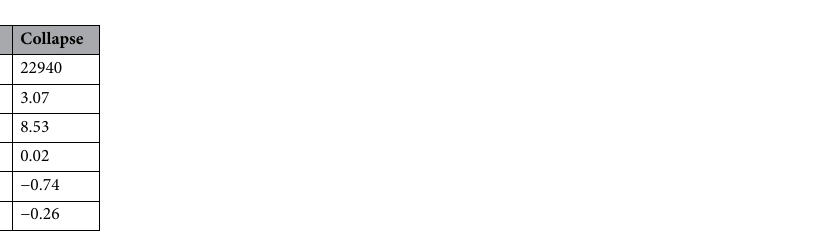
Table 5. Constants from exponential fits for stiffness loss and collapse fatigue failure